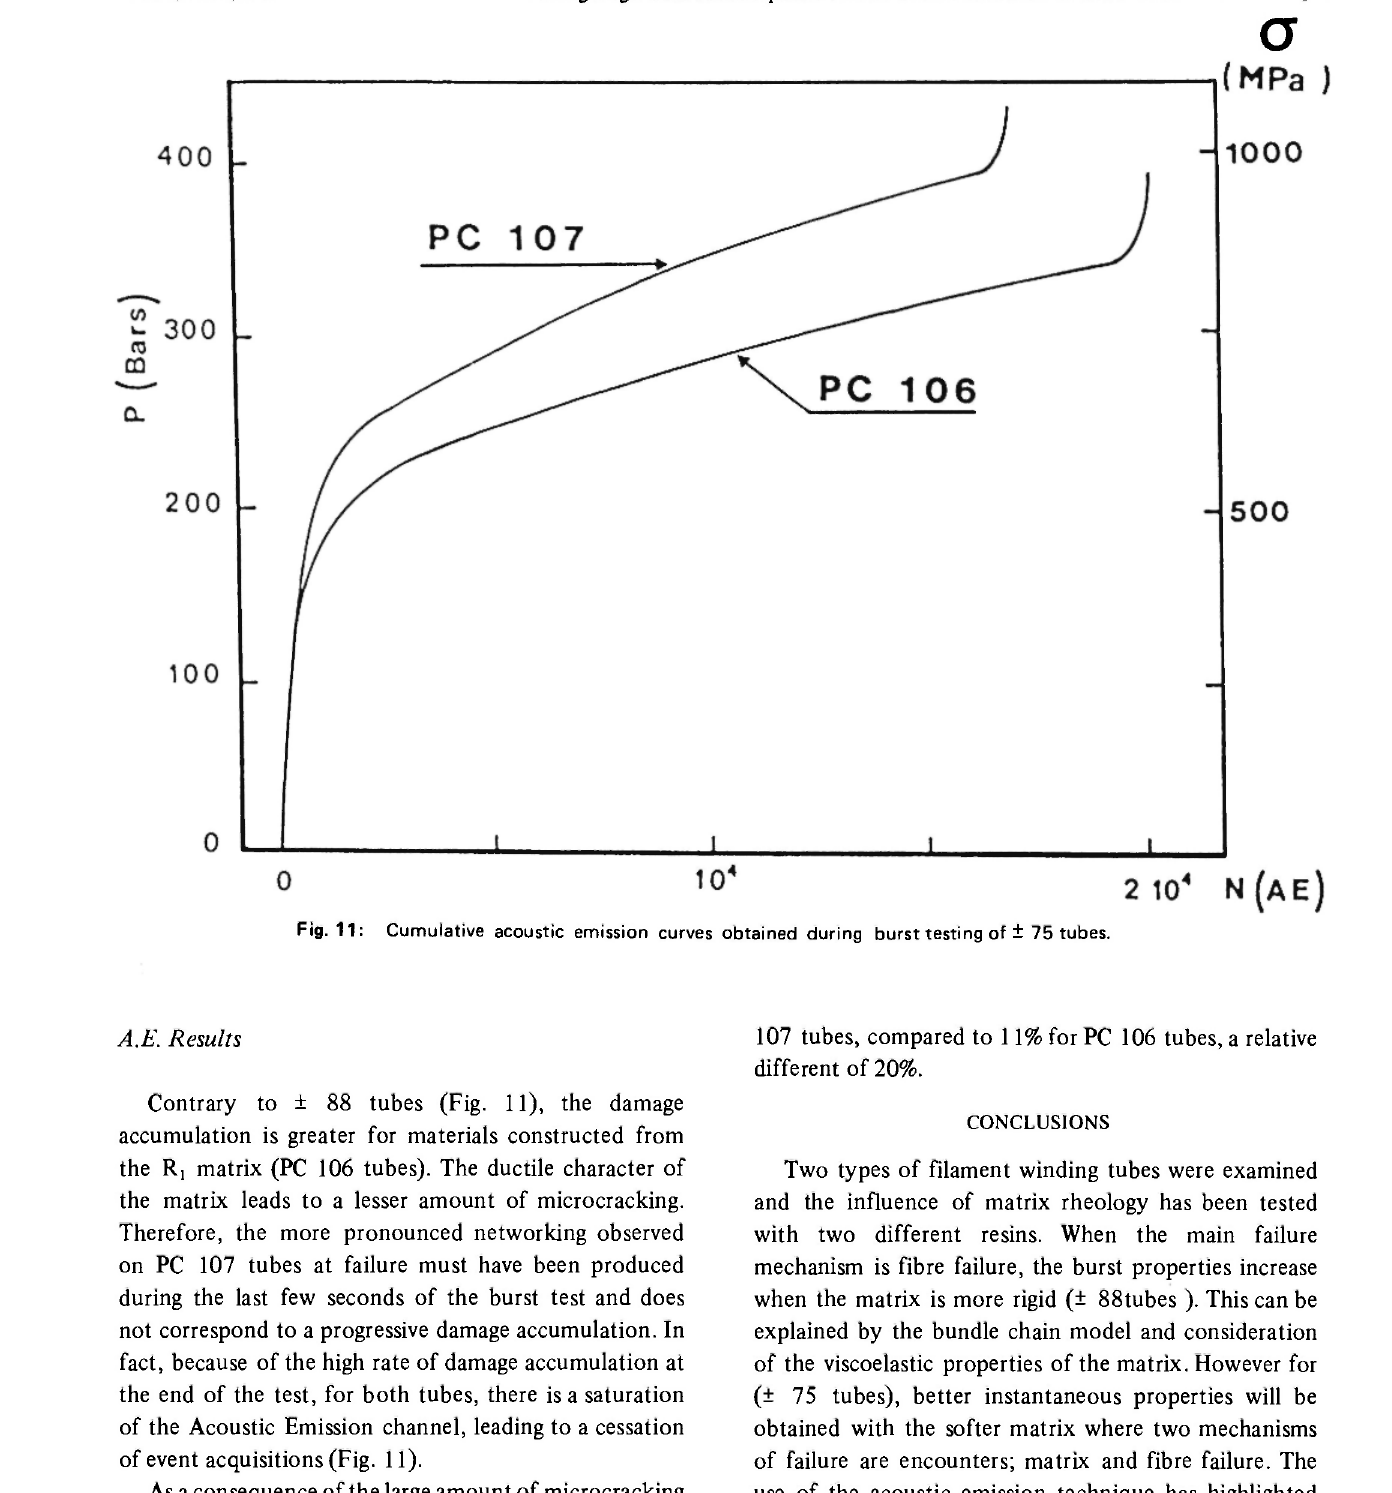
Fig. 11: Cumulative acoustic emission curves obtained during burst testing of ± 75